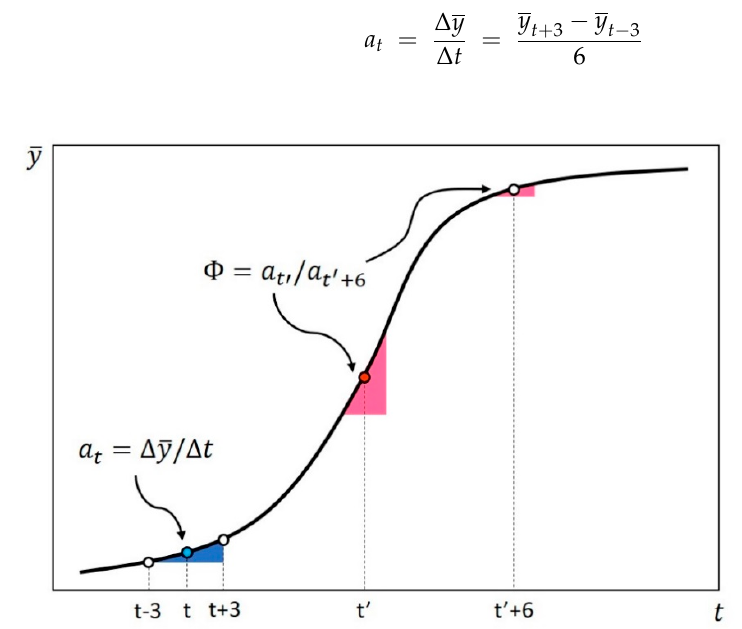
Figure 1. Graphical definition of at and 𝛷